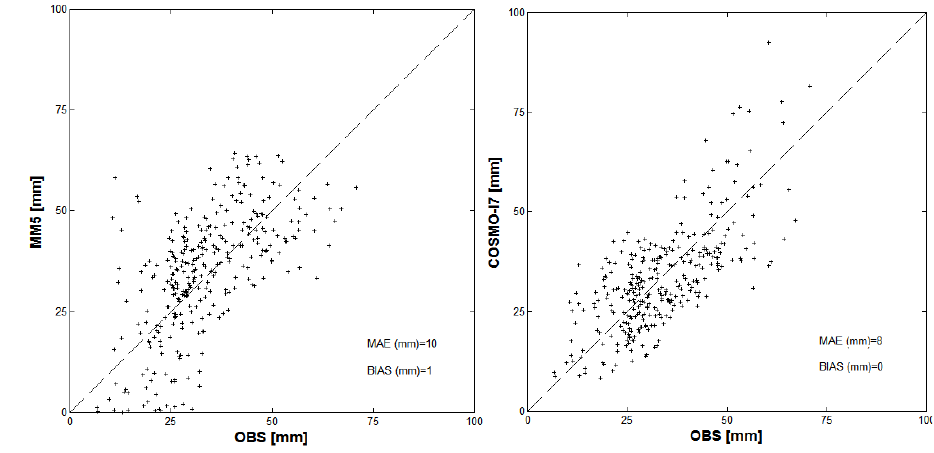
Fig. 17. Case study 5 scatterplots of MM5’s (left) and COSMO-I7’s (right) QPFs against observed rainfall, both exhibiting good skill. Figure 17. Case study 5 scatterplots of MM5‟s (left) and COSMO-I7‟s (right) QPFs 3 Catalonia, which clarifies that their density is not against observed rainfall, both exhibiting good skill. 4